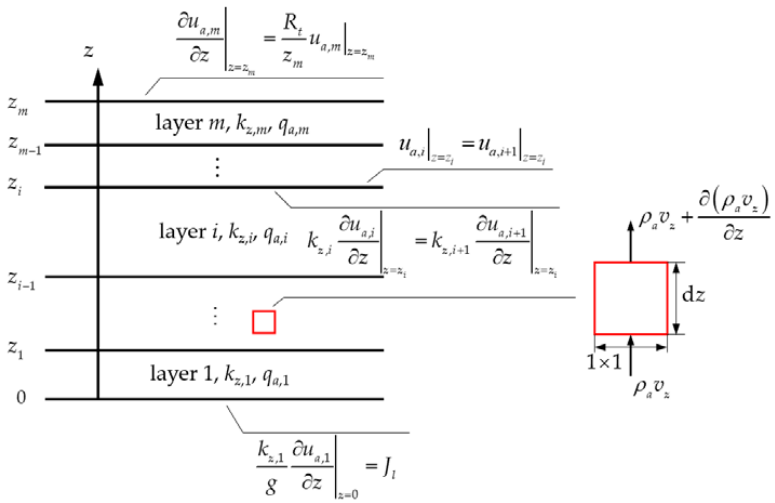
Figure 1. Schematic diagram of the vertical gas flow in a landfill with layered MSW (red rectangle represents a unit of MSW).